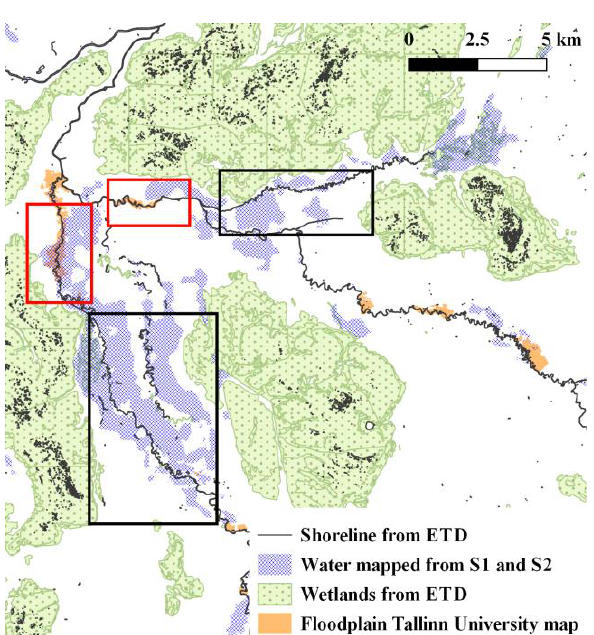
Figure 9. Rivers Halliste, Raudna and Lemmjõgi on different